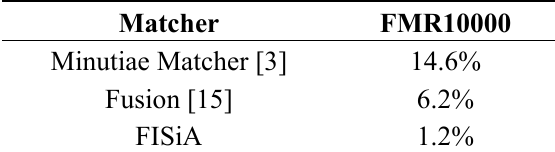
Table 3. Comparison between the minutiae matcher and FISiA on DB_cuts.